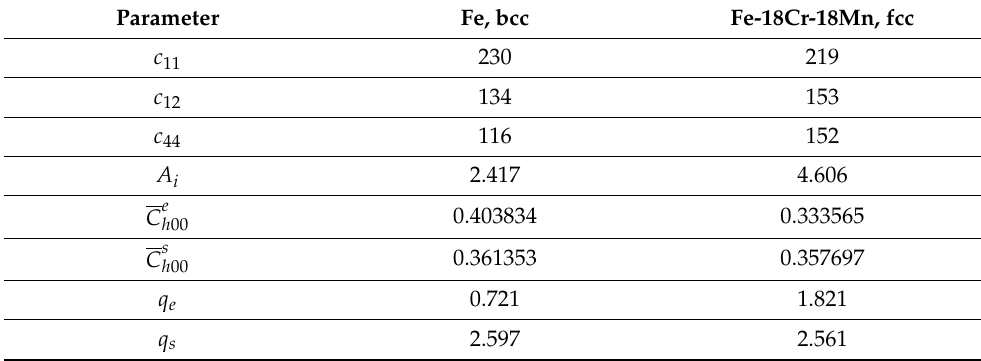
Table 1. Elastic parameters required to implement the strain anisotropy